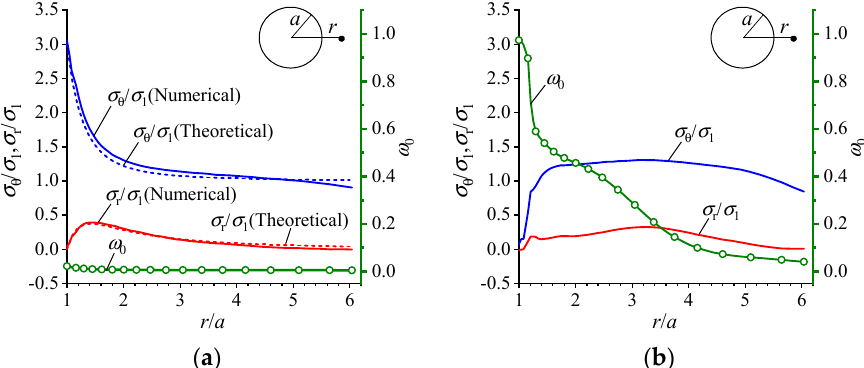
Figure 20. σ r / σ 1 , σ θ / σ 1, and ω 0 vs. r / a along horizontal plane in specimen HA. ( a ) σ 1 = 1 MPa; ( b ) σ 1 = σ p .